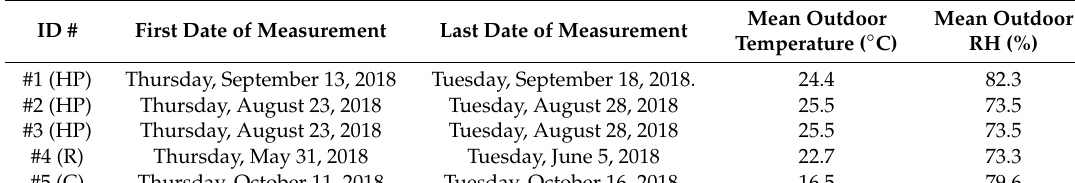
Table 4. Measurement Period of Each School.